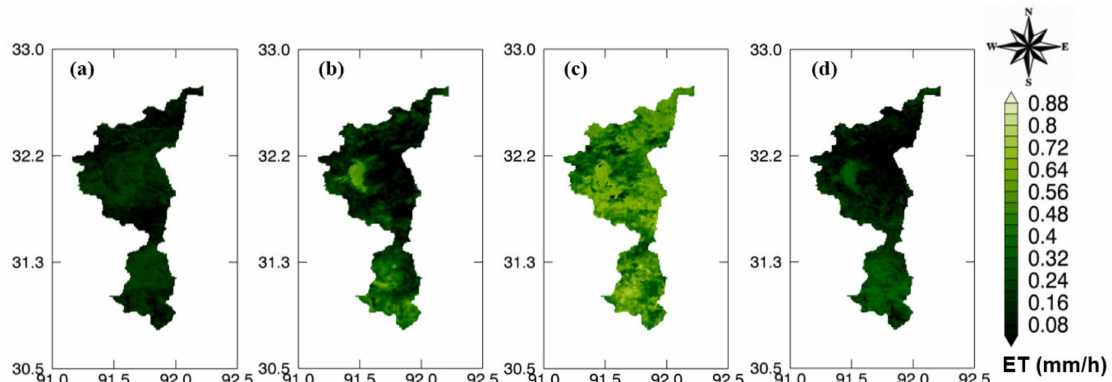
Figure 6. Spatial distribution of mean hourly ET values for January ( a ), April ( b ), May ( c ), and December ( d ) in the Nagqu river